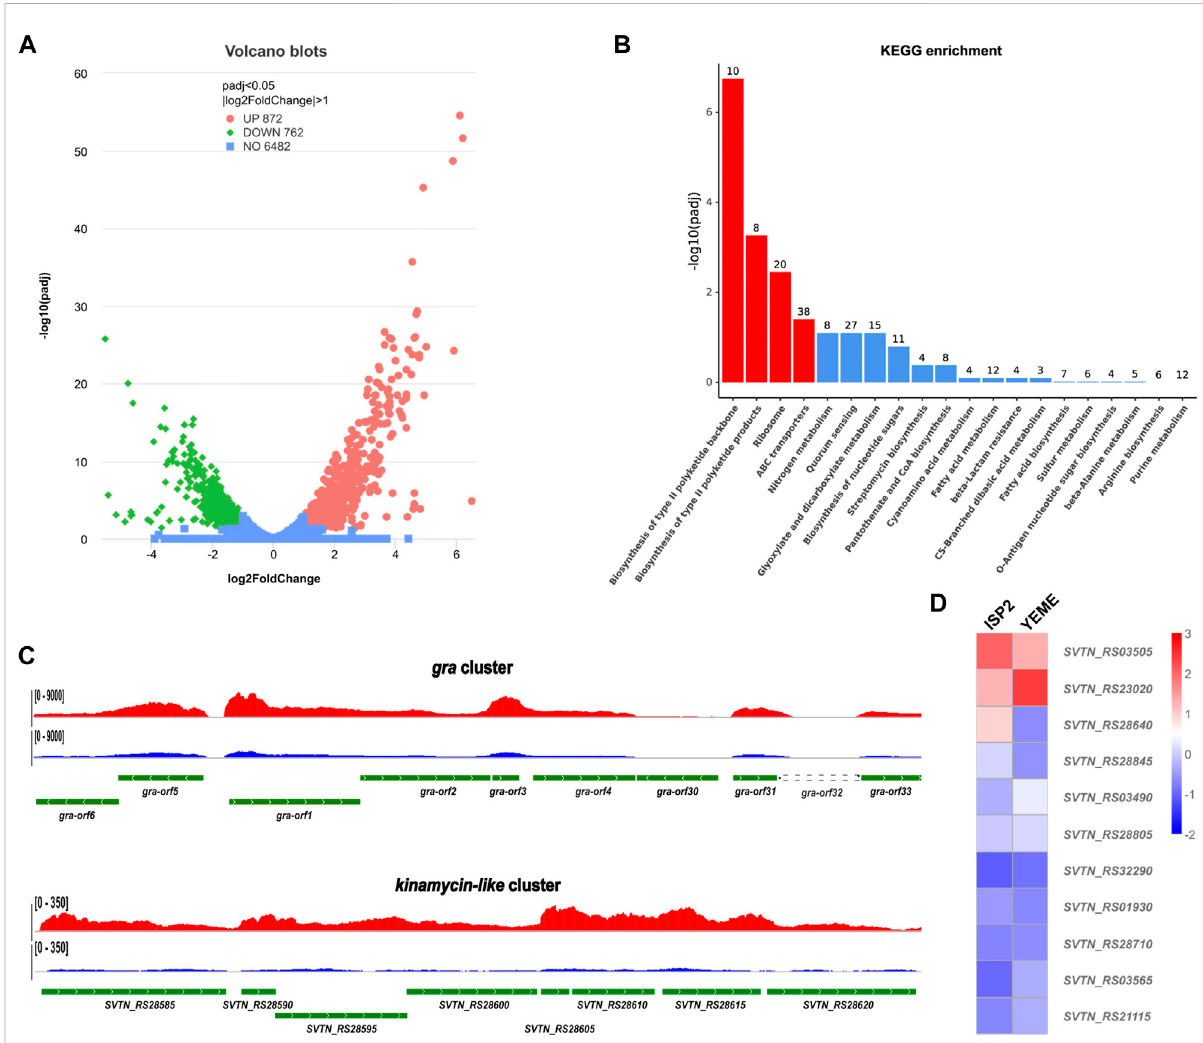
FIGURE 3 Comparative transcriptome analysis of the in-frame deletion mutant Δ gra-orf32 . (A) Volcano blots showing differentially expressed genes (DEGs). Dispersion graph of the -log10(P adjusted) ( y-axis ) against the log2(FoldChange) ( x-axis ). Green and red dots represent genes that were signi fi cantly downregulated and upregulated, respectively, on ISP2 plates at the time point of 24 h, compared to those on YEME plates. (B) KEGG pathwayenrichmentanalysis.Fouroutofthetop20enrichedpathwayswithsigni fi cancywereidenti fi ed(columnsinred).Thetoptwoenriched pathways were type II pathways, namely, the granaticin biosynthetic pathway and thekinamycin-like biosynthetic pathway. The genes enrichedinto these two pathways were all signi fi cantly upregulated. (C) Visualization of RNA-seq across the core parts of the gene clusters of the enriched type II pathways. The read coverage counts for samplesfrom ISP2 and YEME plates werecolored inred and inblue, respectively. (D) Differential expression heatmap of the PPTase genes of S. vietnamensis